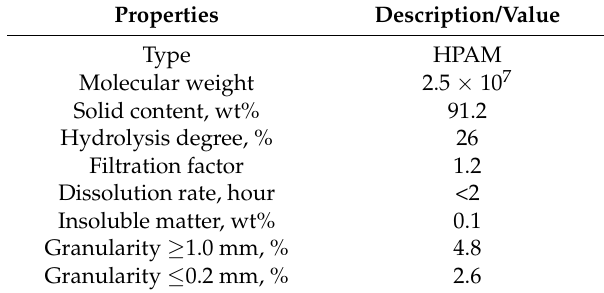
Table 3. Polymer properties.